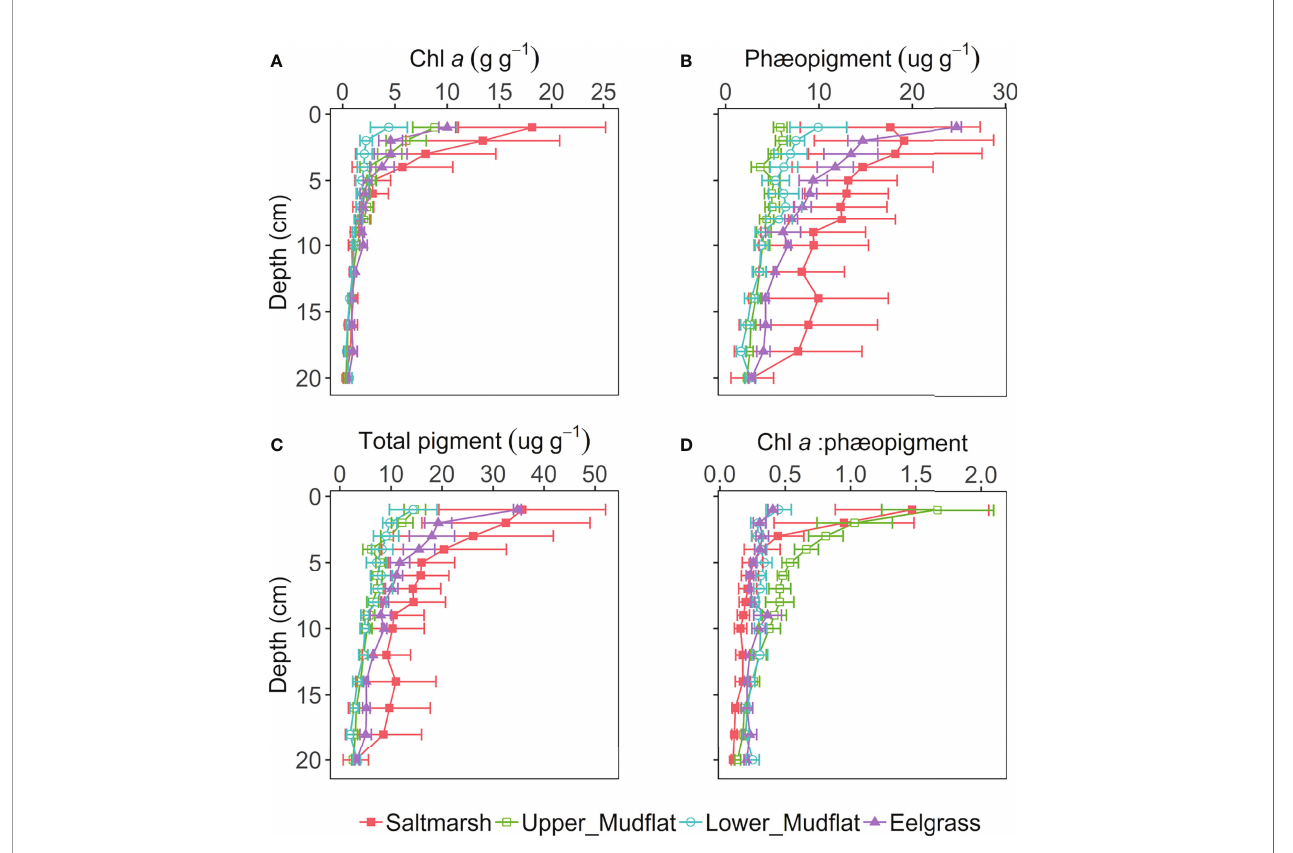
FIGURE 6 | Photosynthetic pigment depth pro fi les in the top 20 cm of sediment of the Cowichan Estuary: (A) chlorophyll a (chl a ) ( m g/g dry sediment); (B) Phæopigment ( m g/g dry sediment); (C) Total pigment ( m g/g dry sediment); (D) Chl a /phæopigment ratio. Horizontal bars represent standard